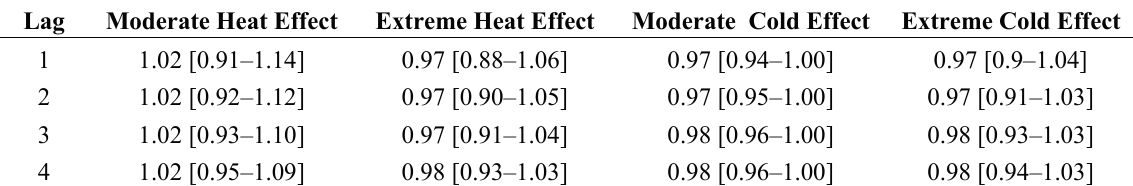
Figure A1. Cumulative risk ratio (RR, 95% confidence interval) of preterm birth up to 30 days for maximum daily temperature (red) and minimum daily temperature (blue) estimated for the warm and cold seasons, respectively. Vertical dashed lines, from right to left: 1st and 25th percentile of minimum daily temperature during the cold season (dotted, blue) ( − 18 °C; − 4 °C), median minimum daily temperature for the annual series (dashed, blue) (4 °C), median maximum daily temperature for the annual series (dashed, red) (10 °C), 75st and 99th percentile of maximum daily temperature during the warm season (dotted, red) (21 °C; 29 °C). Table A1. Lag-specific risk ratio and 95% confidence intervals of the effect of heat and cold in moderate and extreme